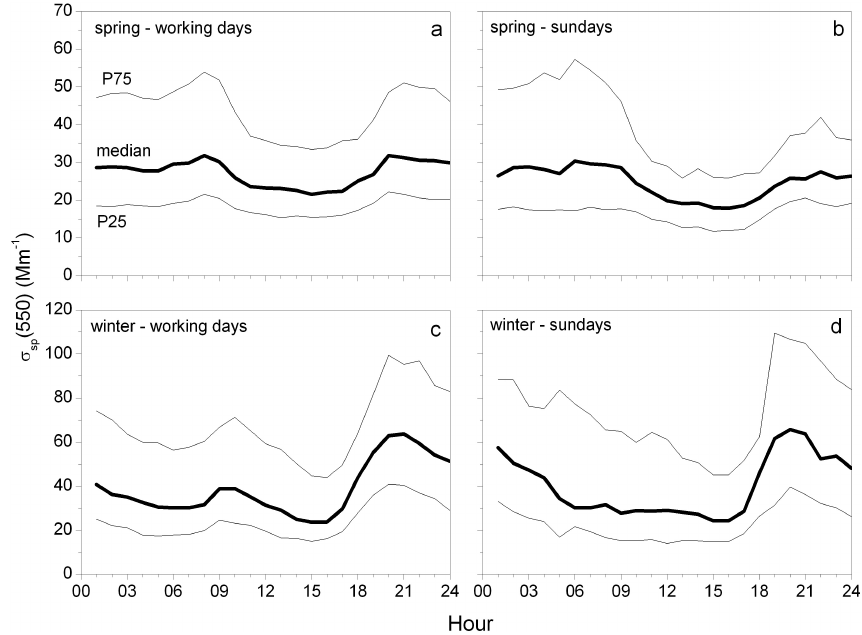
Fig. 6. Daily variation of median values of σ sp (550) for (a) spring working days and (b) Sundays and (c) winter working days and (d) Sundays. The respective quartiles are also